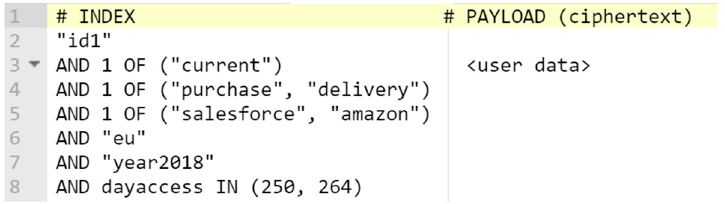
Figure 12. An example of PBE.